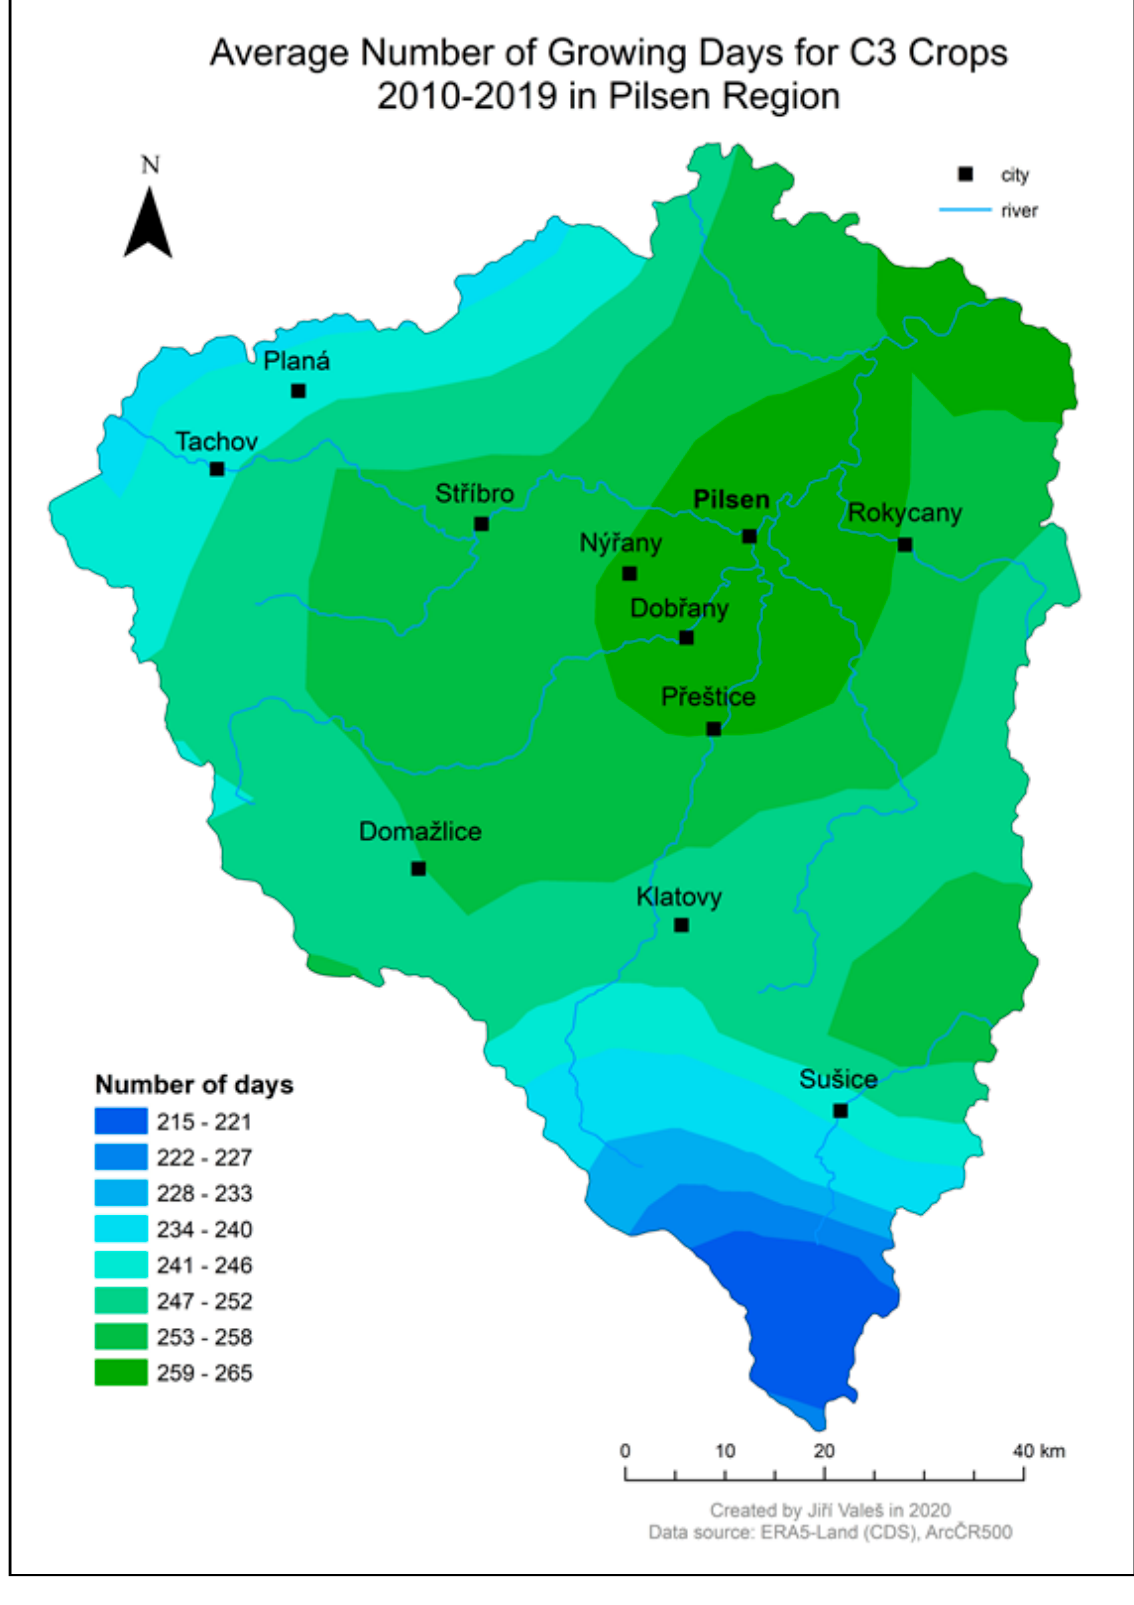
Figure A2. Average Number of Growing Days for C3 Crops 2010–2019 in Pilsen Region.